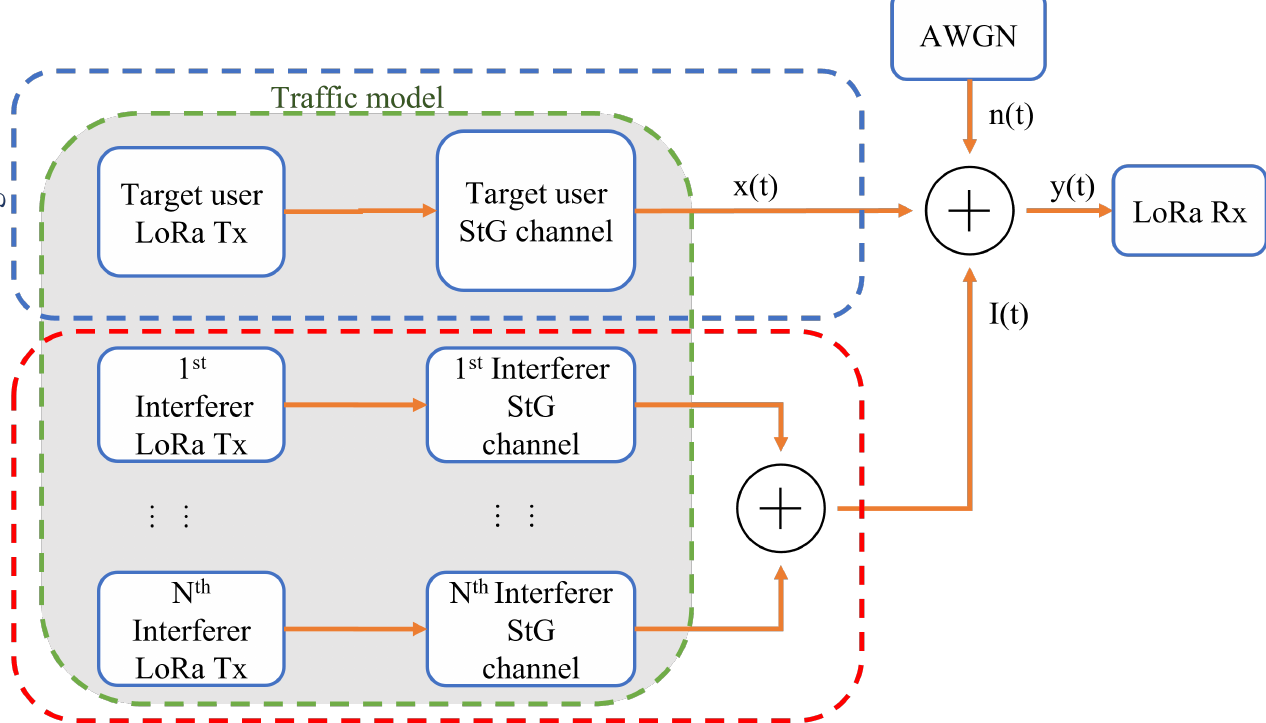
Figure 3. Block diagram of the presented LoRa IoT-over-Satellite emulation framework. The uplink performance is estimated based on practical environment